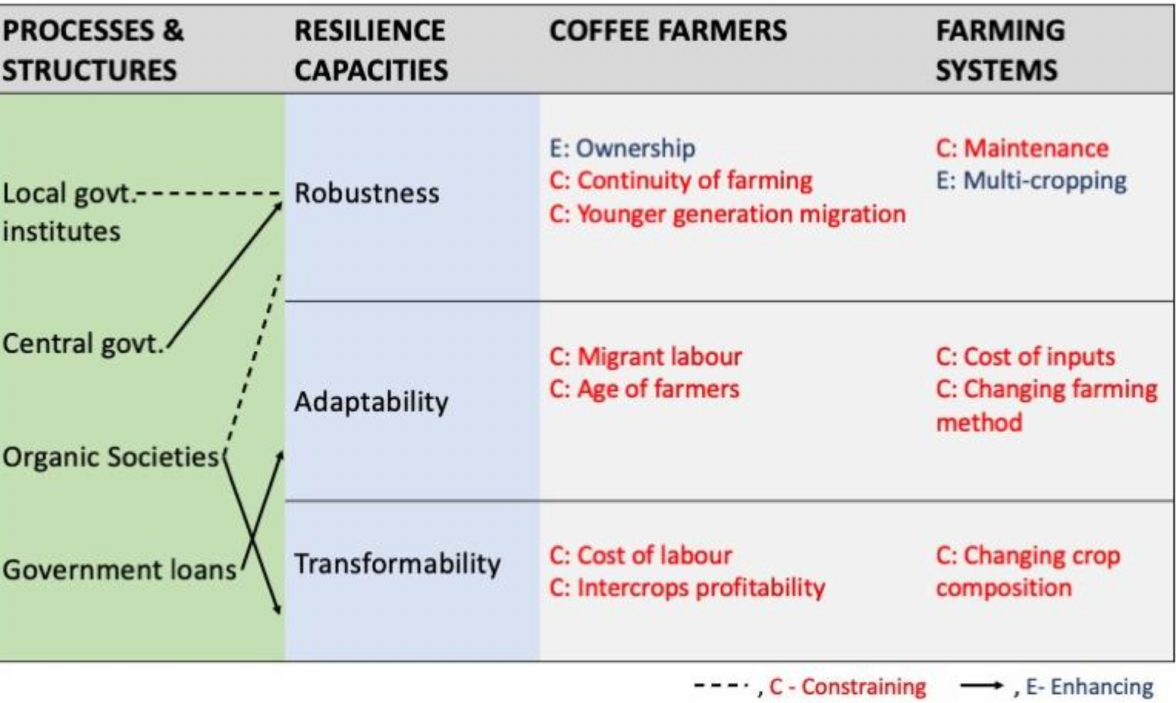
Figure 3. Resilience capacities, processes, and structures of coffee